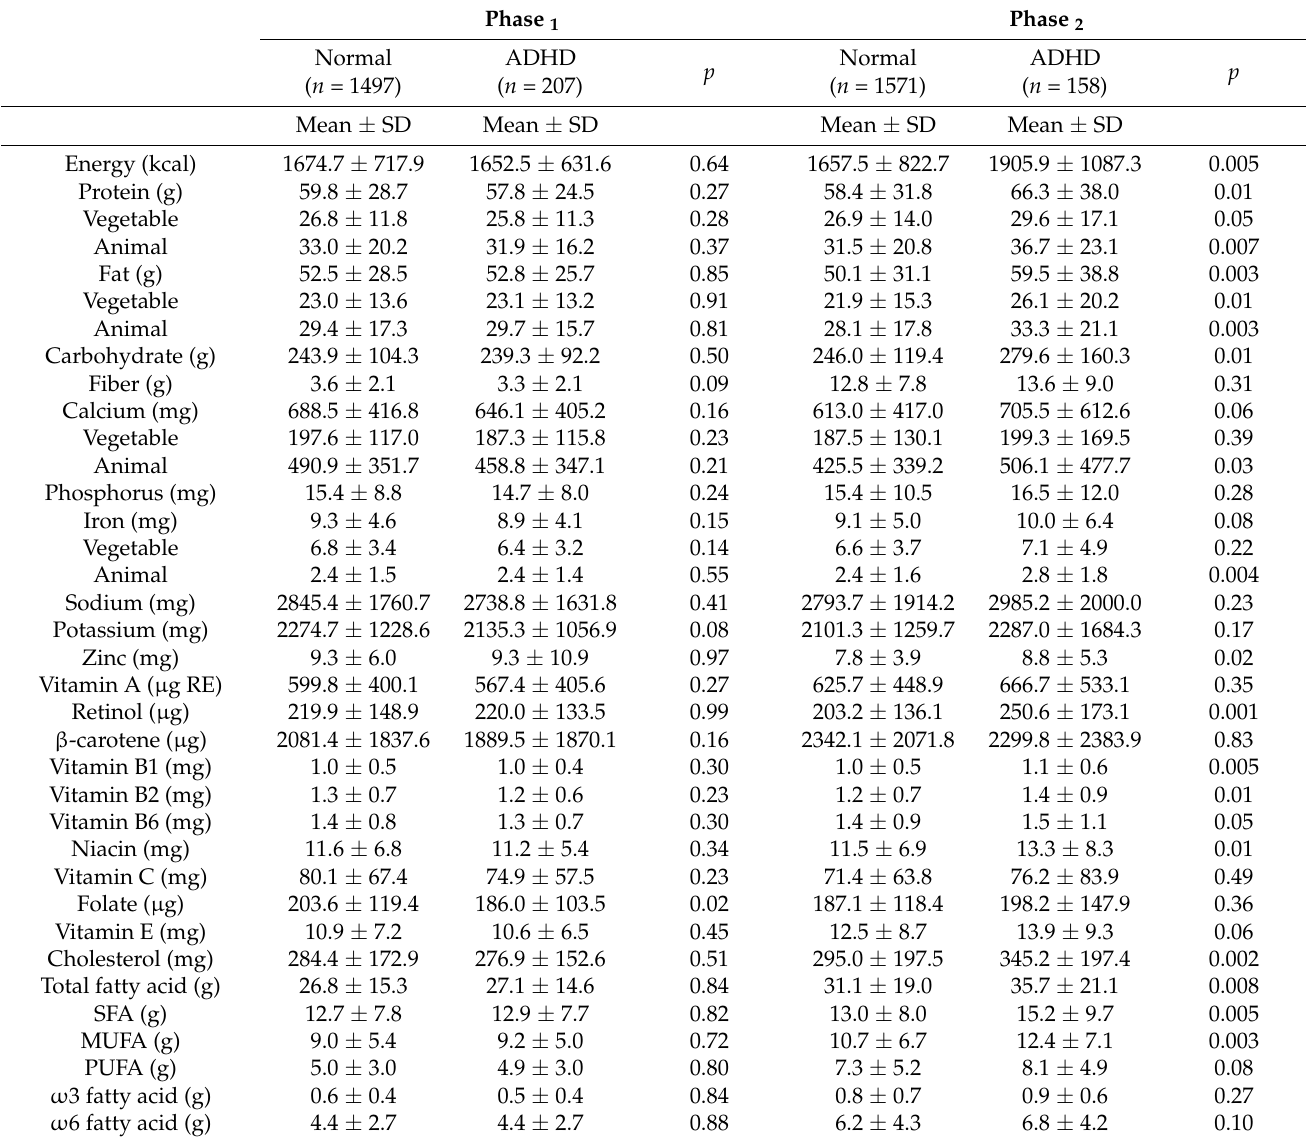
Table 3. Nutrient intake level according to the diagnosis of ADHD (1)